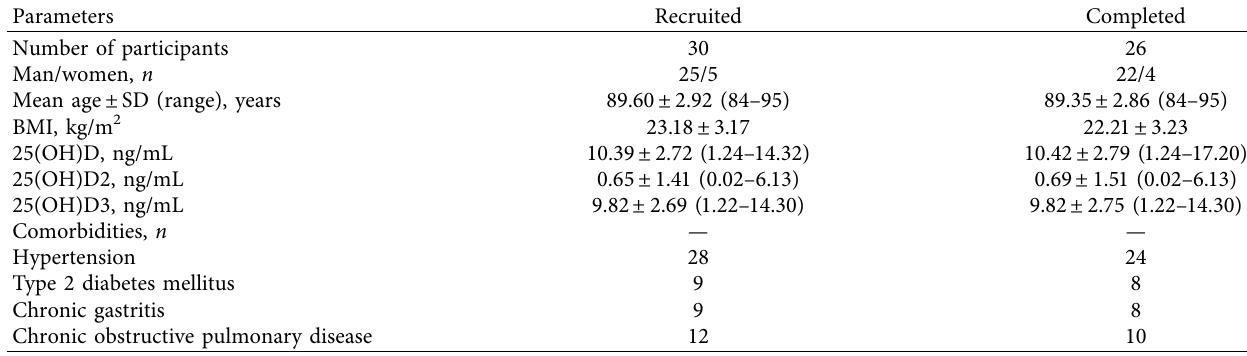
Table 1: Baseline demographic and clinical characteristics of participants.